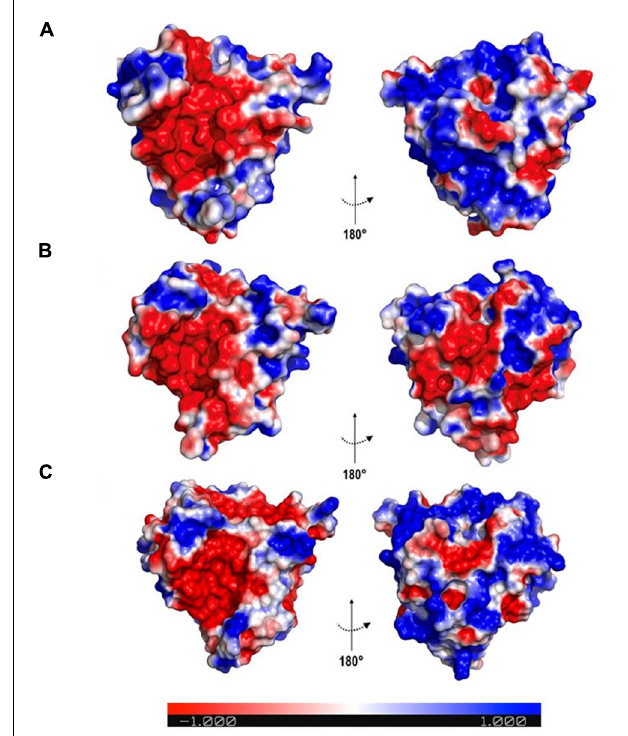
FIGURE 4 | Electrostatic surface potential of osmotin proteins. The colours indicate charges in the electrostatic surface potential; where red, blue , and white represent negative, positive, and neutral regions, respectively. (A) Sni_SnOLP image representing the electrostatic surface potential of Solanum nigrum and Nicotiana tabacum osmotins. (B) Gma_OLPb image representing the electrostatic surface potential of Glycine max osmotins, except Gm_P21-like. (C) Gma_P21-like. Images generated with PyMOL Molecular Graphics System version 1.5.0.4 (Schrödinger,